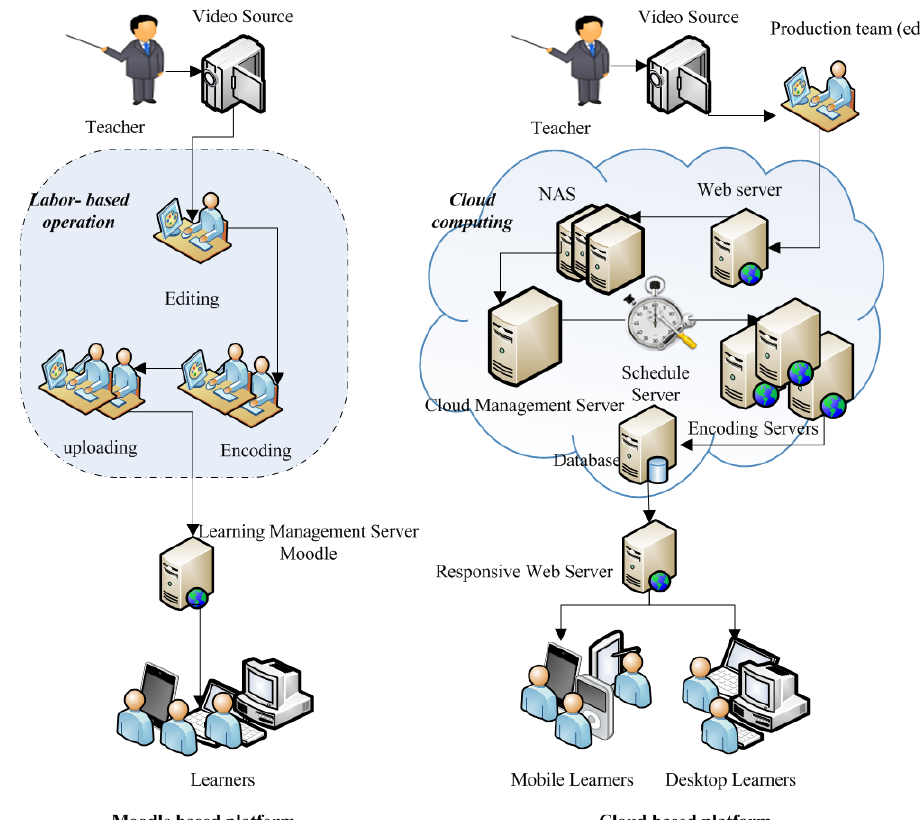
Figure 5 . System architecture of Moodle-based and cloud-based